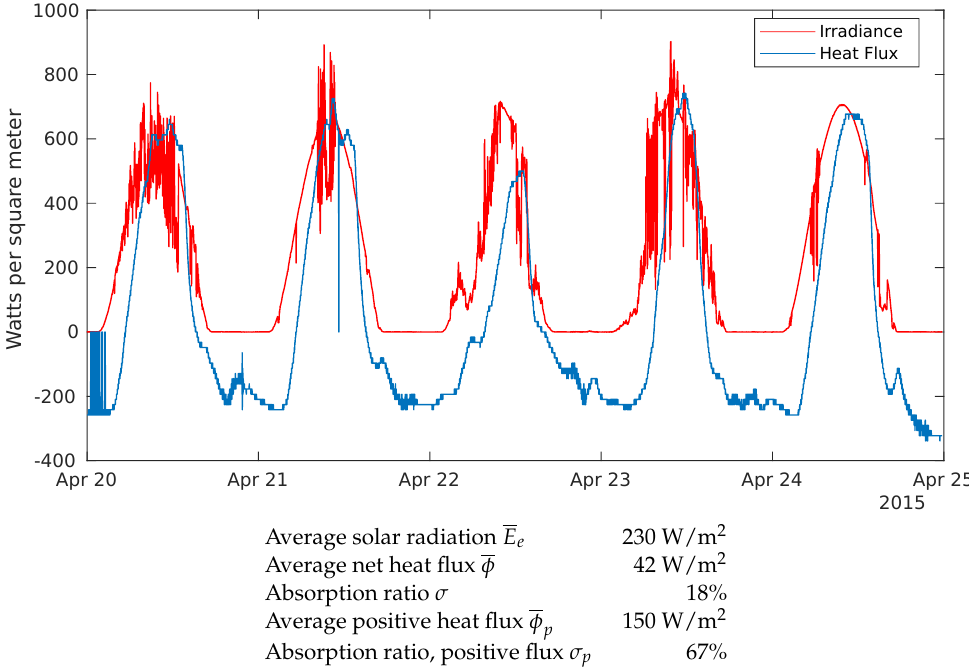
Figure 9. Instantaneous solar irradiation E e [W/m 2 ] and heat flux [W/m 2 ] from 20 to 25 Apr 2015 (spring) as function of time (day) and their estimated average values.